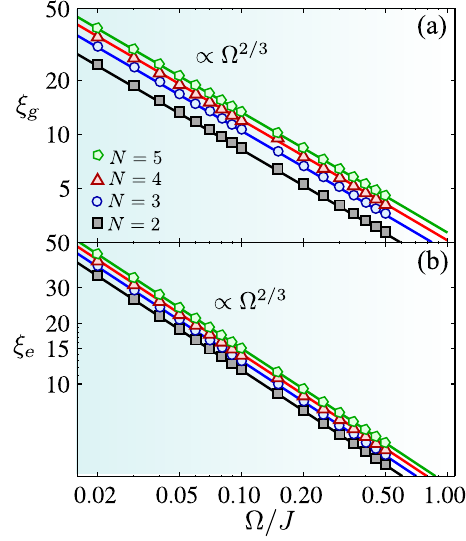
FIG. 4. Comparison of the localization lengths (a) ξ given by the variational Ansätze (solid lines) with infinite bath size and the DMRG results (markers) with 1000 bath sites at Δ =J ¼ 0 in the N ¼ 2 , 3, 4, 5